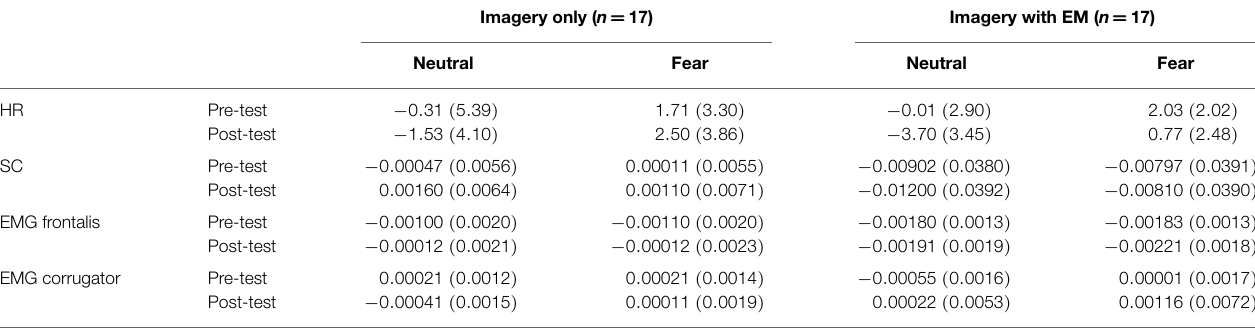
TABLE 1 | Mean change scores for physiological measures during imagery of neutral and fear scripts .